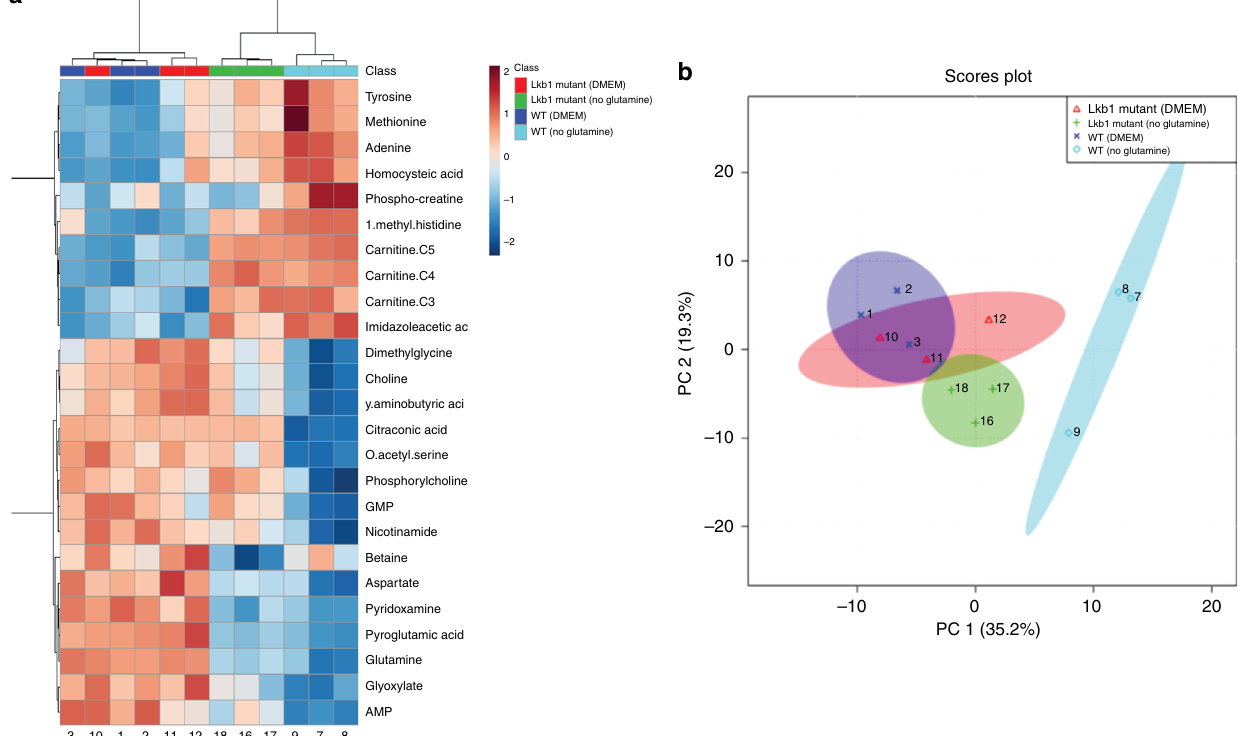
Fig. 3 Metabolomics analysis of wild-type and Lkb1 mutant kidneys. Heatmap showing relative abundance of the 25 most signi fi cantly affected metabolites extracted from samples of cultured kidneys from embryonic day 13.5 wild-type and Lkb1 mutant kidneys cultured in control media (DMEM) and DMEM- glutamine. The colorbar presented is a log2 scale ( a ). Principal Component Analysis (PCA) of wild-type and Lkb1 mutant kidneys in the presence and absence of glutamine ( b